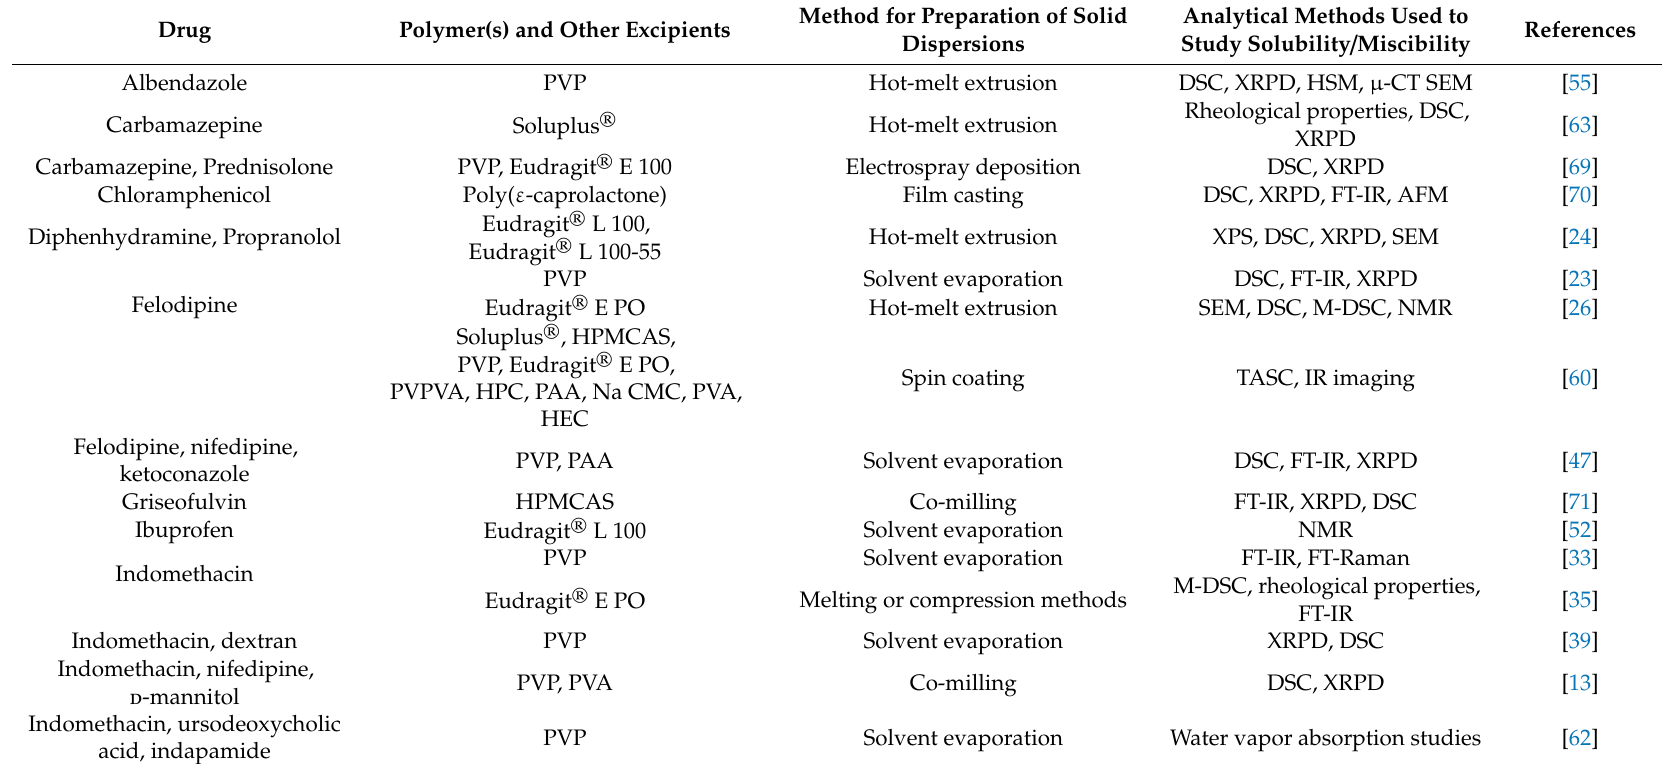
Table 1. Examples of analytical methods used for the characterization of solid